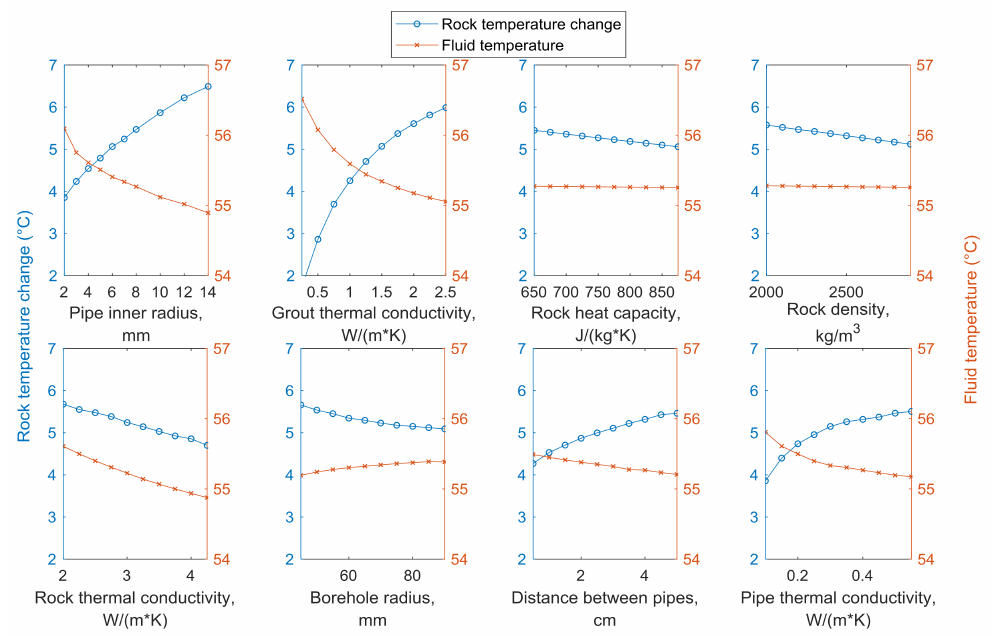
Figure 13. Fluid outlet temperature and maximum rock temperature change at MOBH after 21 days of heating as a function of the input parameters. Both y -axes have the same range for all parameters to indicate their relative influences on the